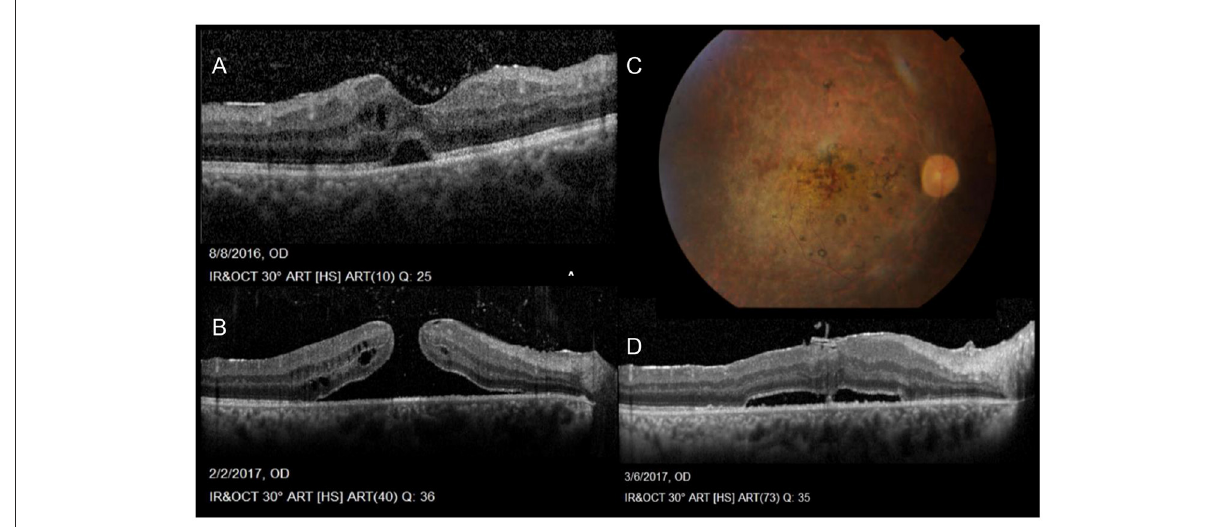
FIGURE1 Sequelae of Behçet Uveitis: (A) Cystoid macular edema, epiretinal membrane, neurosensory detachment and vitreous opacities denoting vitritis (B) Progression of the cystoid changes in to a full thickness, macular hole (C) Color photos Post vitrectomy sealing of the hole, also showing severely attenuated vessels, pale discs and laser marks (D) OCT post PPV showing residual NSD following vitrectomy with peeling of ILM and sealing of the hole (Series courtesy of Dr. Soliman MM, MD).